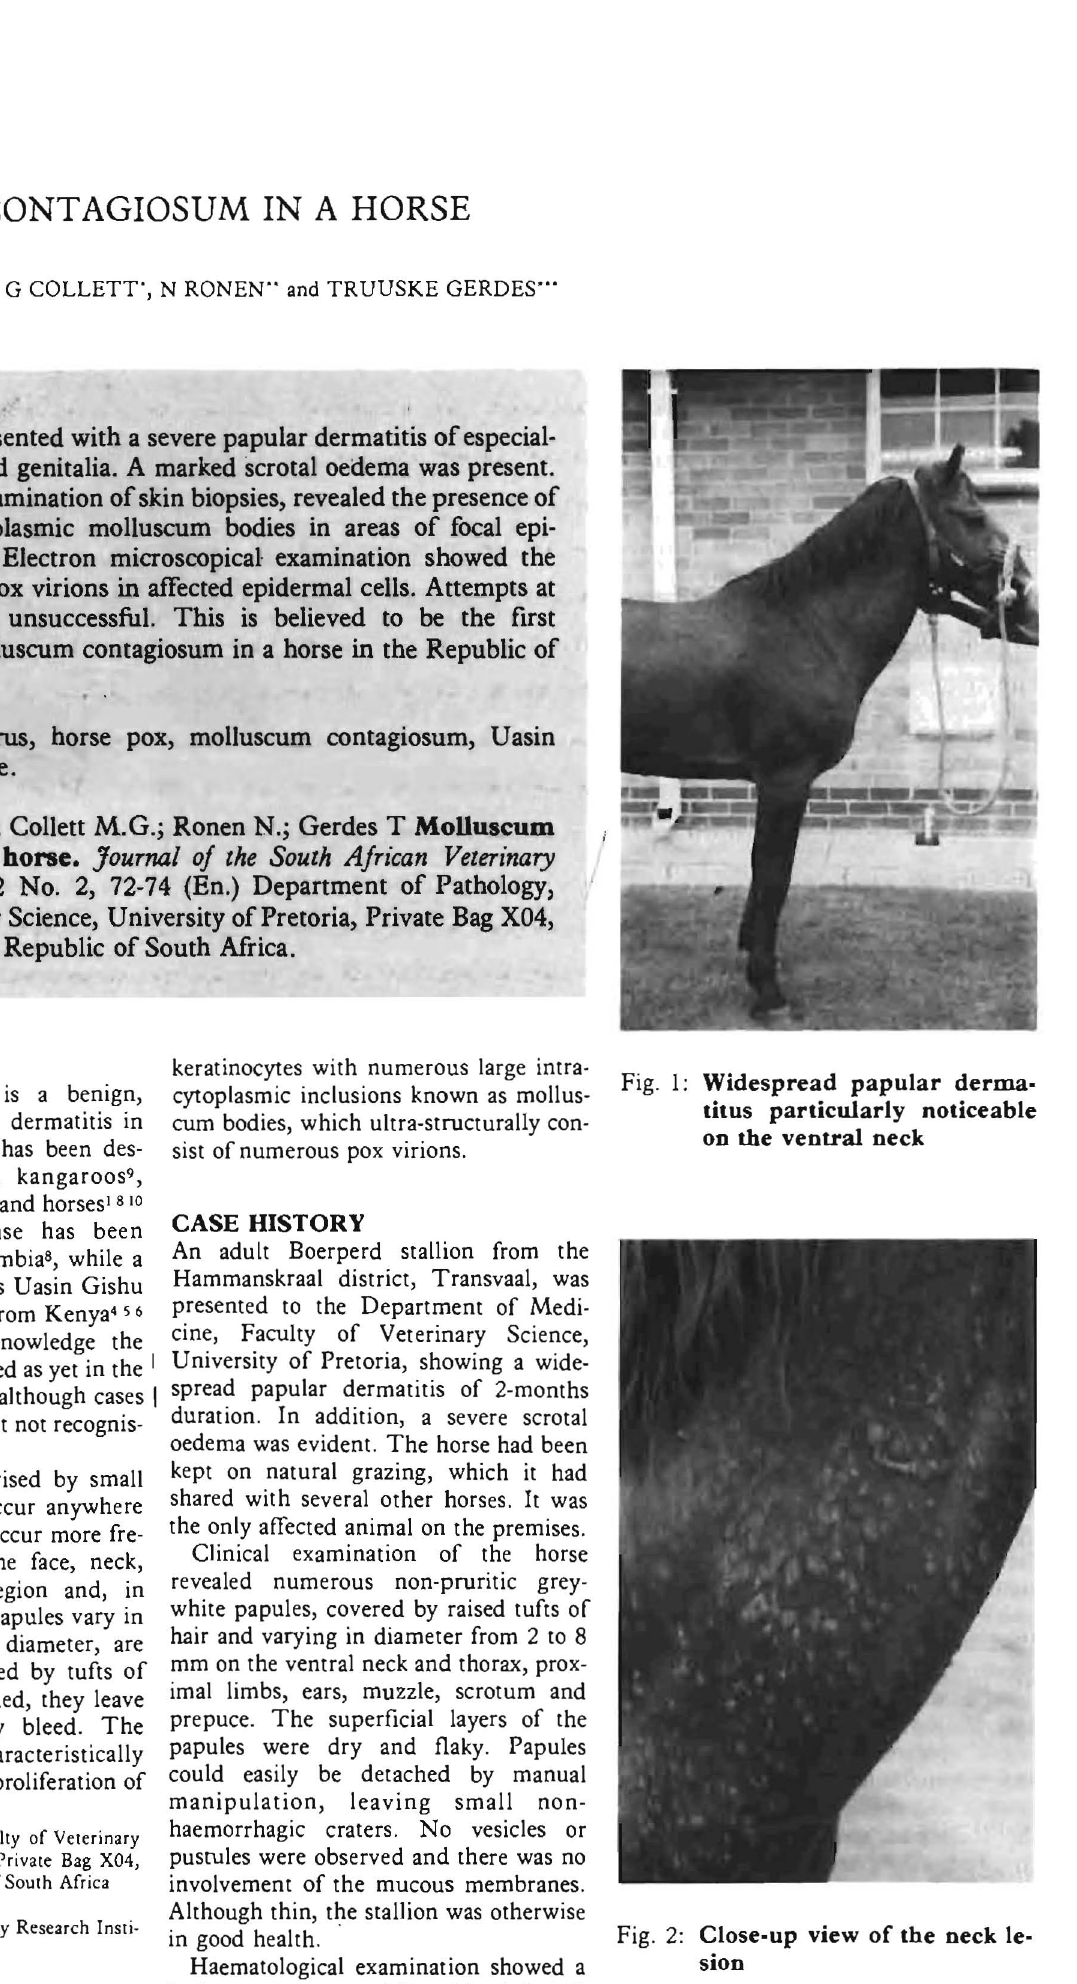
Fig. 2: Close-up view of the neck le